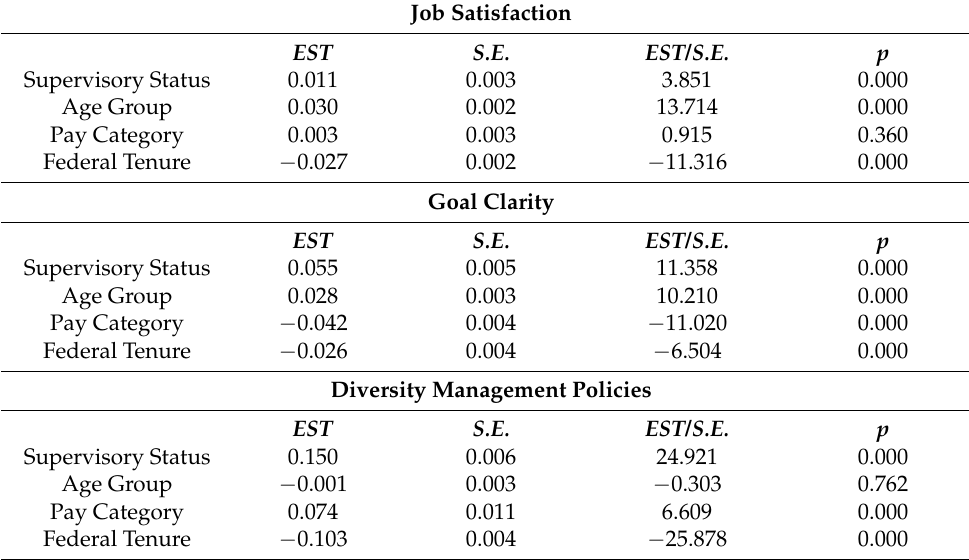
Table 3. Standardized parameters for control